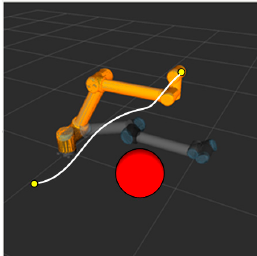
Figure 3. High-dimensional static RRT planning scenario.